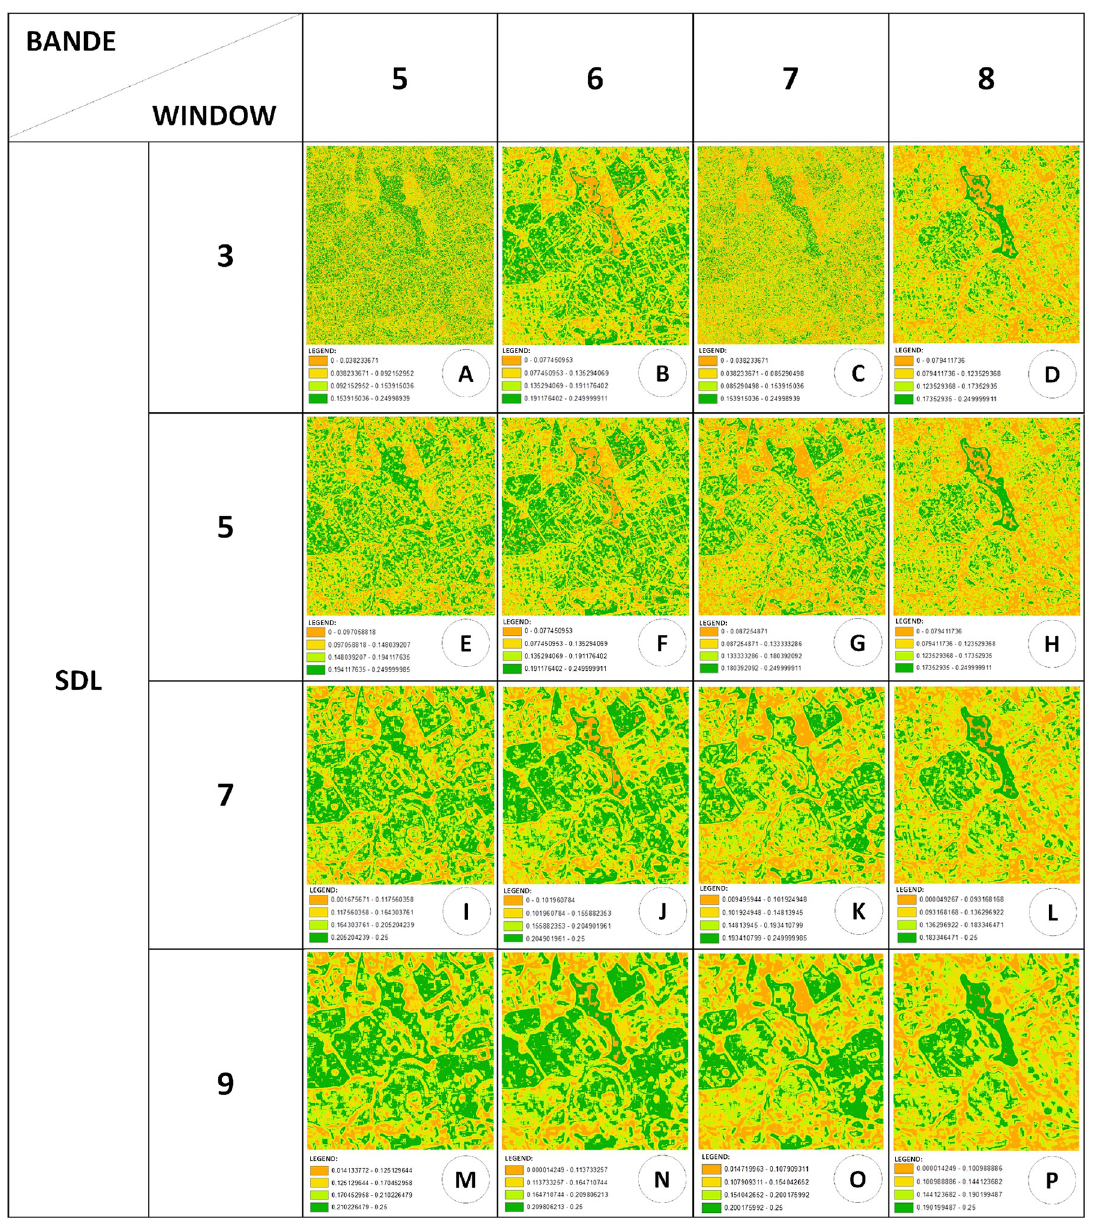
Fig 10. Landscape complexity maps generated by CompPlex Janus for SDL measure applied to different window sizes and bands for a CBERS MUX level-4 image of Itirapina Ecological and Experimental Parks and their surroundings (State of Sao Paulo,